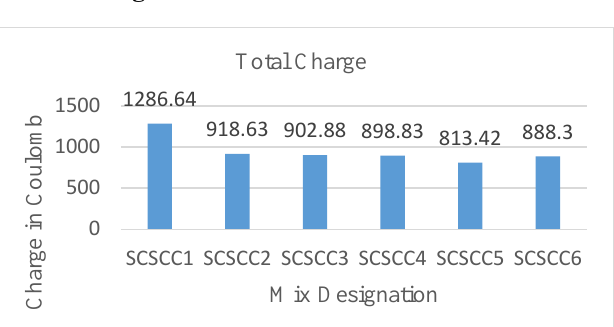
Fig. 25. RCPT Results for NSSCC.